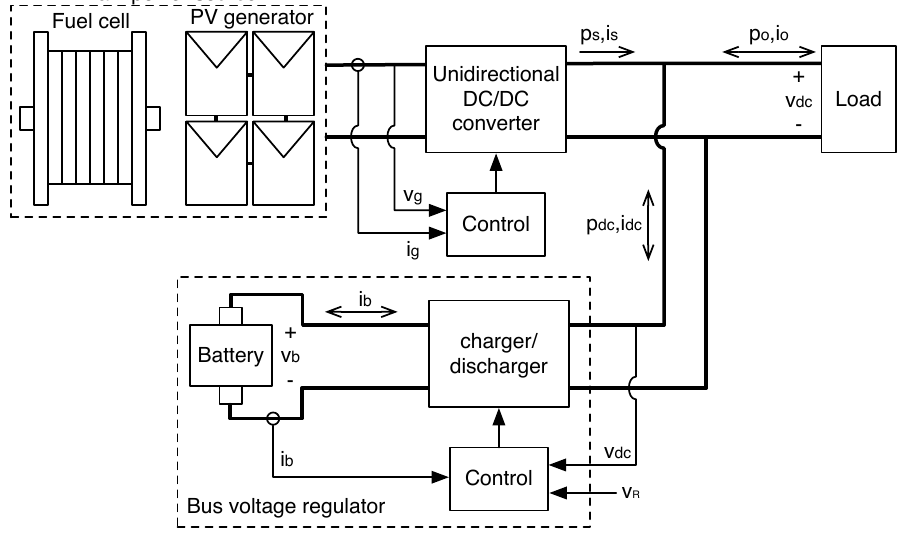
Figure 1. Stand-alone power system with bus voltage